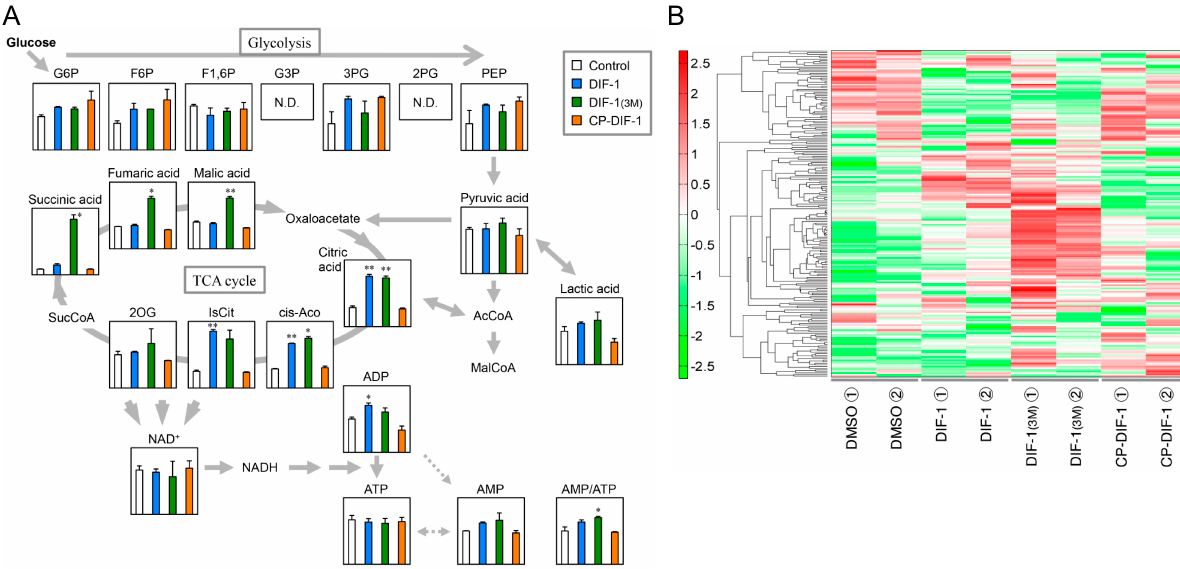
Figure 7. Metabolome analysis. ( A ) Effects of DIFs on glucose metabolism in confluent 3T3-L1 cells. Cells were incubated for 3 h with 0.1% DMSO (Control) or 20 μ M of DIF-1, DIF-1 (3M) , or CP-DIF-1, and metabolite levels per 10 6 cells were determined by use of CE-TOFMS to construct a metabolome pathway map. The metabolites levels in the control cells were set to 1, and the relative amounts in the DIF-treated cells are presented as the mean and SD of the duplicate samples. * p < 0.05 versus Control. N.D., not detected; G6P, glucose 6-phosphate; F6P, fructose 6-phosphate; F1,6P, fructose 1,6-diphosphate; G3P, glyceraldehyde 3-phosphate; 3PG, 3-phosphoglyceric acid; 2PG, 2-phosphoglyceric acid; PEP, phosphoenolpyruvic acid; AcCoA, acetyl CoA_divalent; MalCoA, malonyl CoA_divalent; cis-Aco, cis-aconitic acid; IsCit, isocitric acid; 2OG, 2-oxoglutaric acid. ( B ) Heat map of cellular metabolites. Of the 205 metabolite peaks identified in this study, metabolites showing similar relative abundance throughout the 4 duplicated samples were clustered into a metabolome heat map. The horizontal axis shows the sample names, and the vertical axis shows the metabolites. HCA (hierarchical cluster analysis) was performed, and the distance between the peaks is shown in the dendrogram. Green, small average abundance; red, large average abundance.